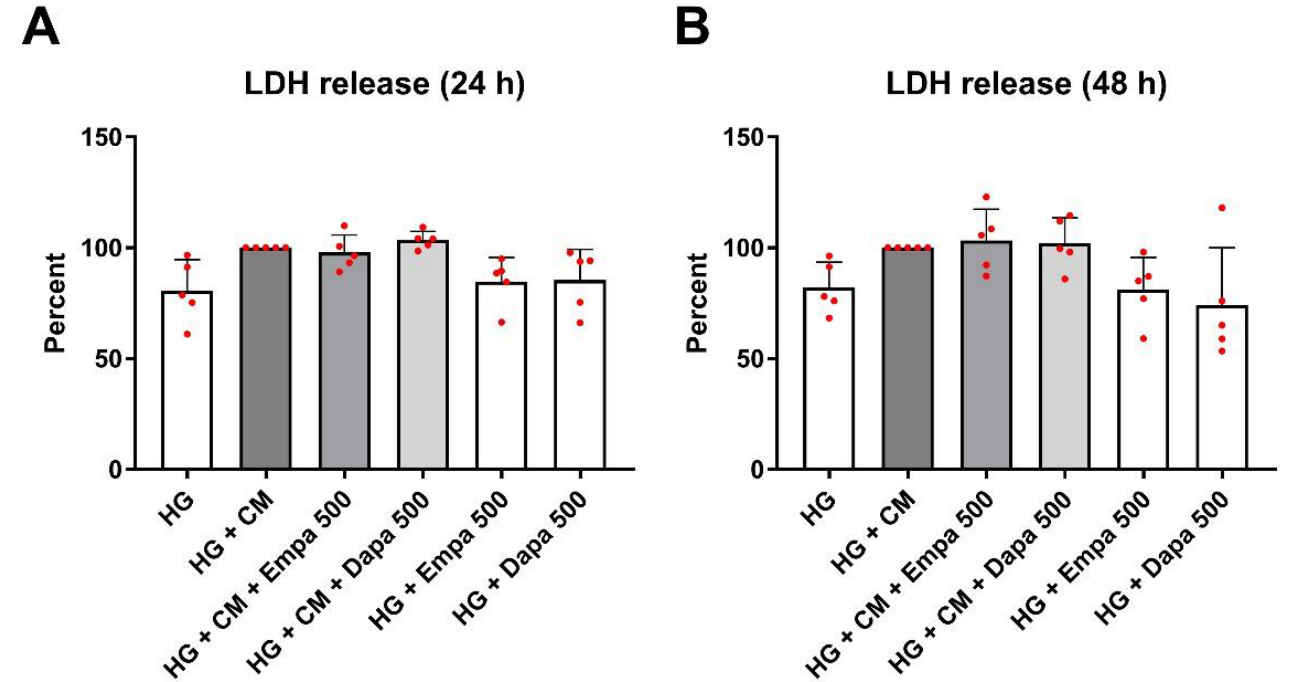
Figure 1. Cytotoxic effects under diabetic and inflammatory culture conditions (lactate dehydroge- nase (LDH) assay). The measurement of LDH activity released from the cytosol of damaged cells into the supernatant was used for the quantification of cell death and lysis. The PTCs cultured in 96-well plates were incubated for 24 ( A ) or 48 h ( B ) in media containing empa- or dapagliflozin under a diabetic (high glucose) or diabetic in combination with an inflammatory (cytokine mix, CM) environment. No significant effects of the different treatments on cytotoxicity were detected (analysis of variance (ANOVA) with Dunnett’s multiple comparison test). Absorbance was measured in a microplate reader (490 vs. 650 nm, arbitrary units, calculated as a percent in relation to the control (HG + CM), scatter plots with bar, mean ± SD, n = 5).